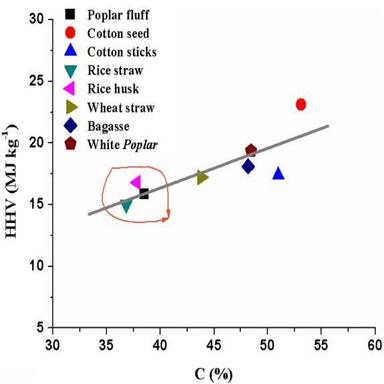
Correlation between carbon content and HHV of the raw materials, Poplar fluff (this study), Poplar wood, as well as agricultural and crop residues (as reference).